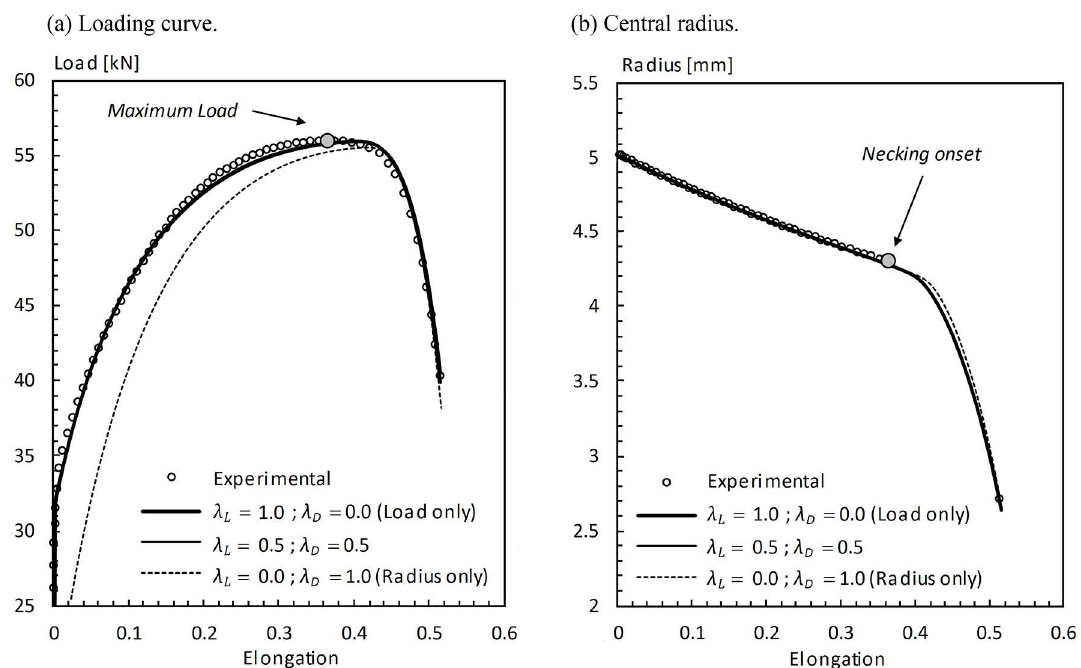
Figure 3. Bergström's yield stress equation : evolution of the tensile load and specimen central radius.